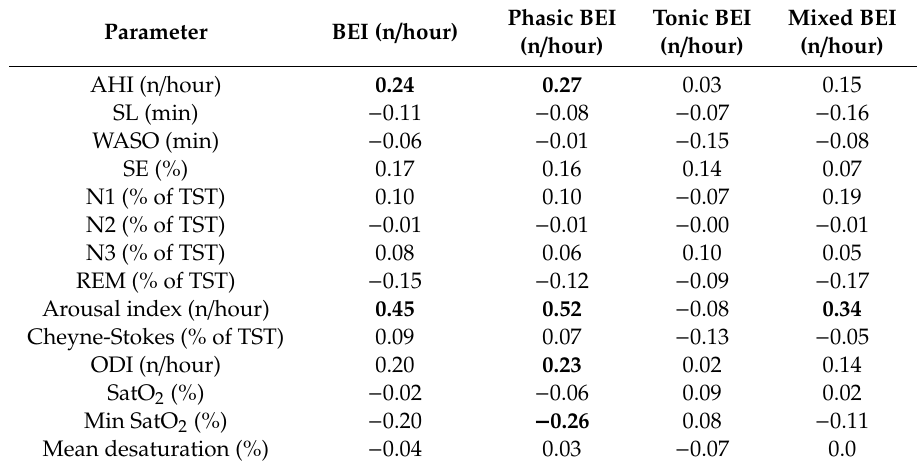
Figure 1. Correlation scatter plots between apnea–hypopnea index (AHI) and bruxism episode index (BEI) in the whole group, in the group with AHI < 30 and in the group with AHI ≥ 30. A positive linear correlation was observed between phasic bruxism and oxygen desaturation index (ODI) and between phasic bruxism and minimal oxygen saturation in the group with AHI <30 (Table 3). Table 3. The correlations between polysomnographic indices and BEI in the group with mild and moderate OSA (AHI < 30). Parameter